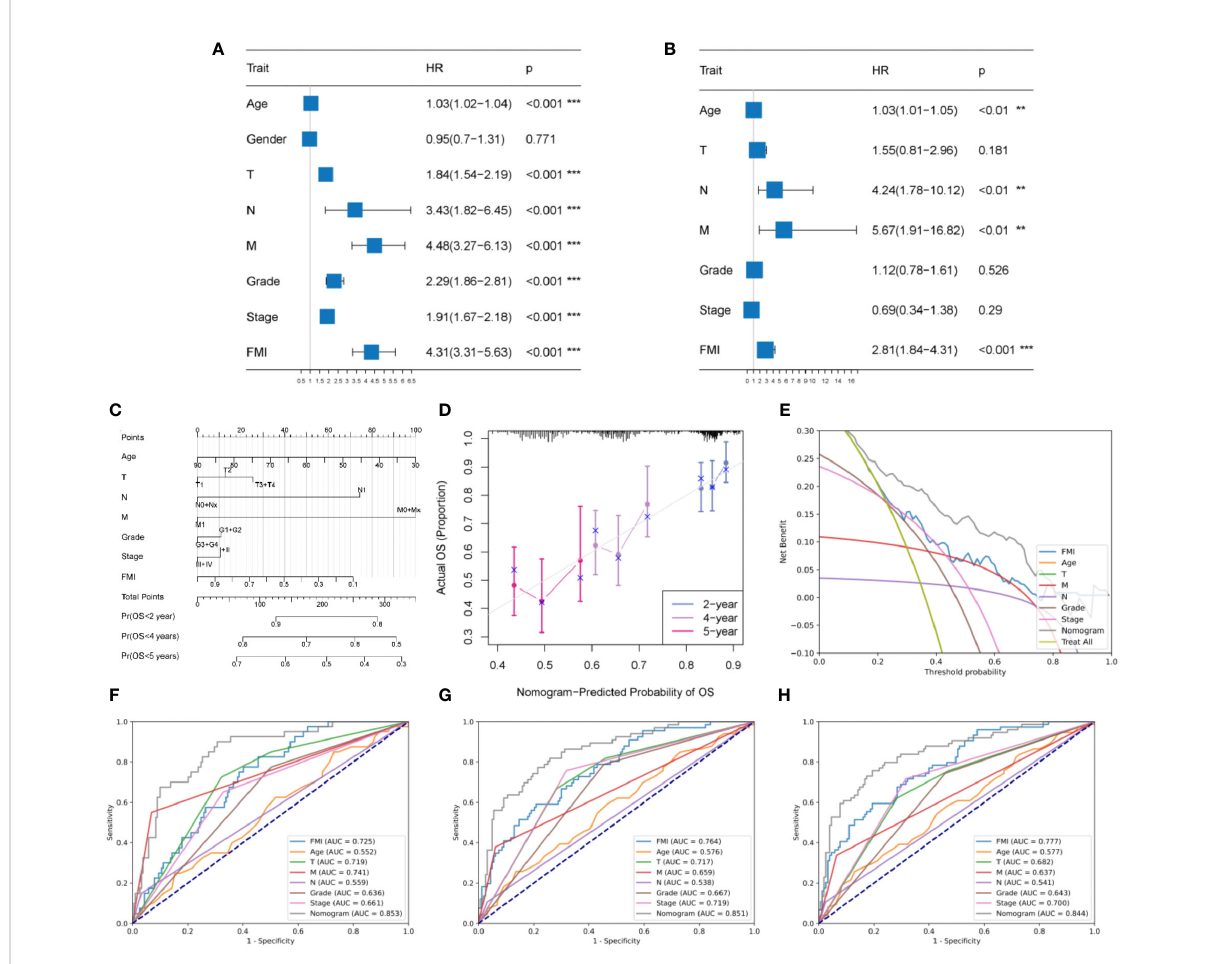
FIGURE 5 Development and evaluation of a clinicopathologic nomogram based on the identi fi ed FMGs. (A, B) Univariate and multivariate Cox regression analyses. (C) Development of a prognostic nomogram based on age, T stage, N stage, M stage, tumor grade, AJCC stage, and FMI. (D) Calibration curve showing the predicted OS versus actual OS. (E) DCA of the clinical usefulness of the constructed nomogram. (F, G, H) Receiver operating characteristic (ROC) analysis of the nomogram for predicting 2-, 4-, and 5-year OS in the TCGA-KIRC cohorts. ** P < 0.01; *** P <